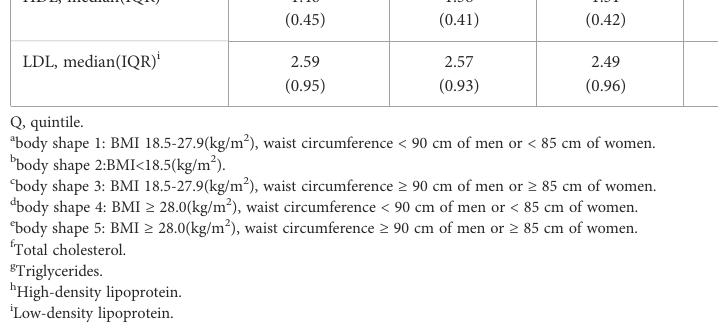
indicate that neutrophils and lymphocytes have some predictive values for T2D. The results of the longitudinal analysis showed that the results of the univariate Cox regression of the relationship between neutrophils and T2D were signi fi cant ( P -value < 0.05). TABLE 5 HR for developing diabetes in nondiabetes patients across leukocyte and its subsets quintiles.